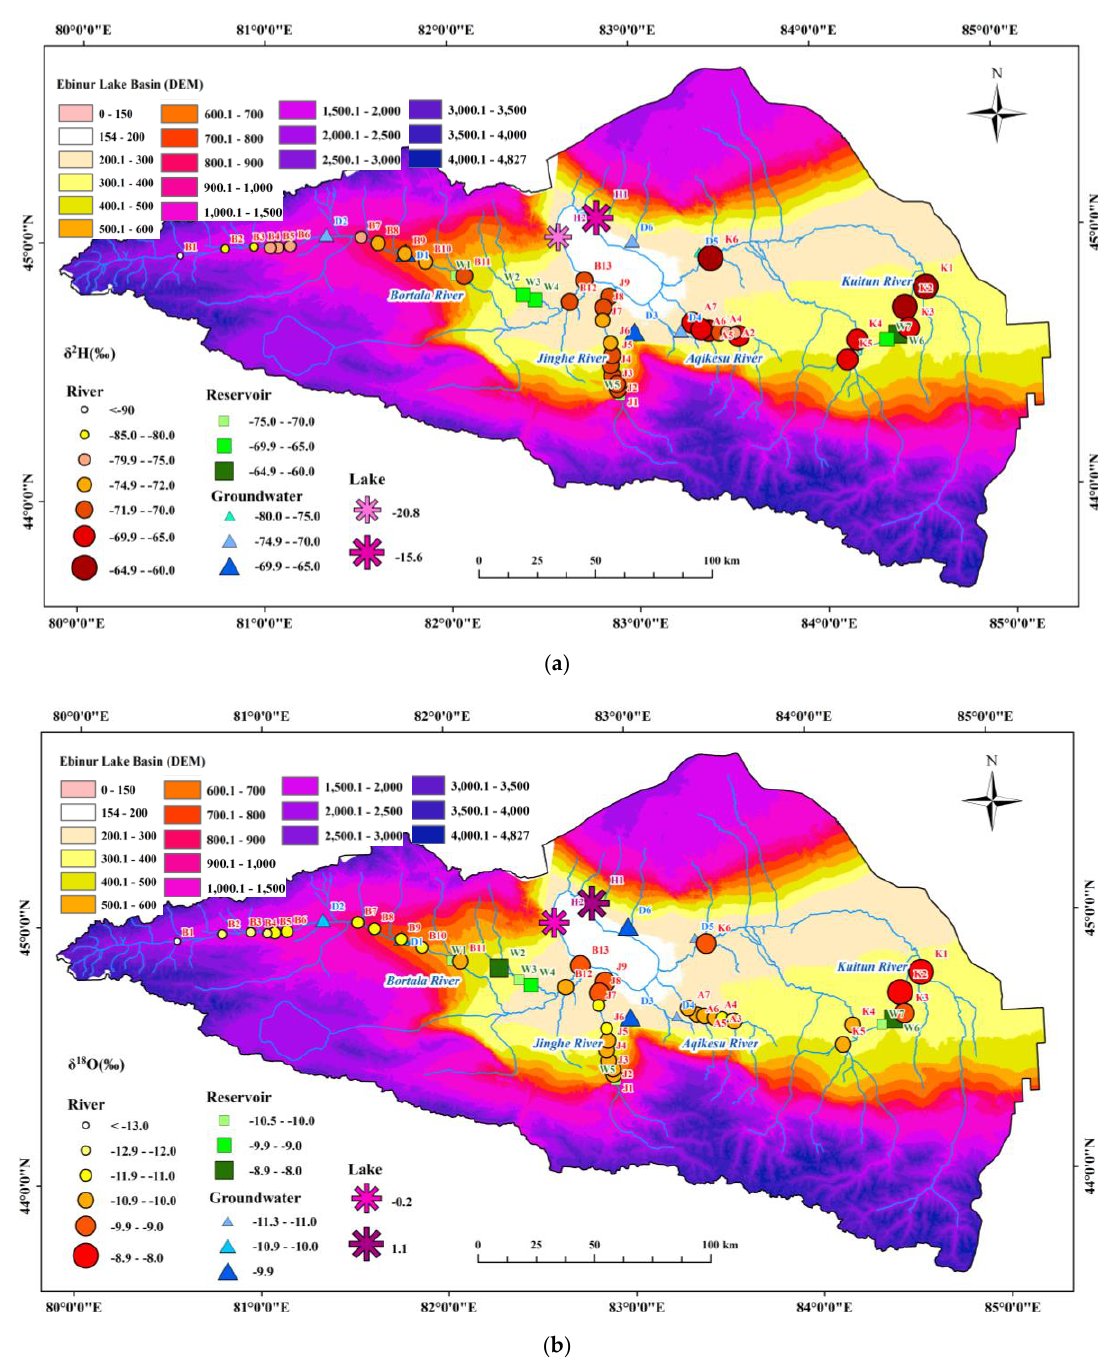
Figure 13. Spatial distribution of ( b ) δ 18 O, ( a ) δ 2 H, and elevation of different water bodies.